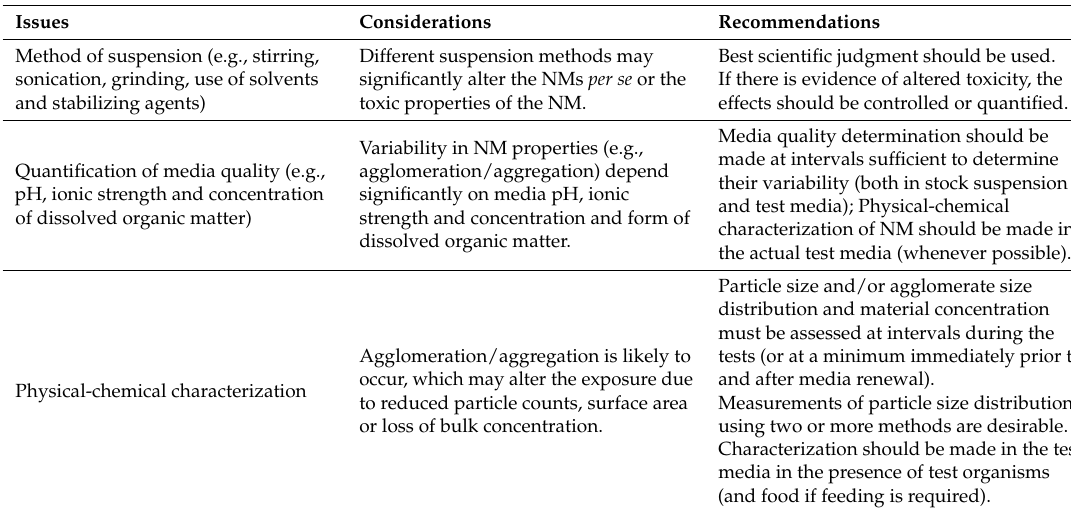
Table 2. Overview of issues and considerations regarding preparation of samples of NMs in exposure media for aquatic ecotoxicity studies. Data from